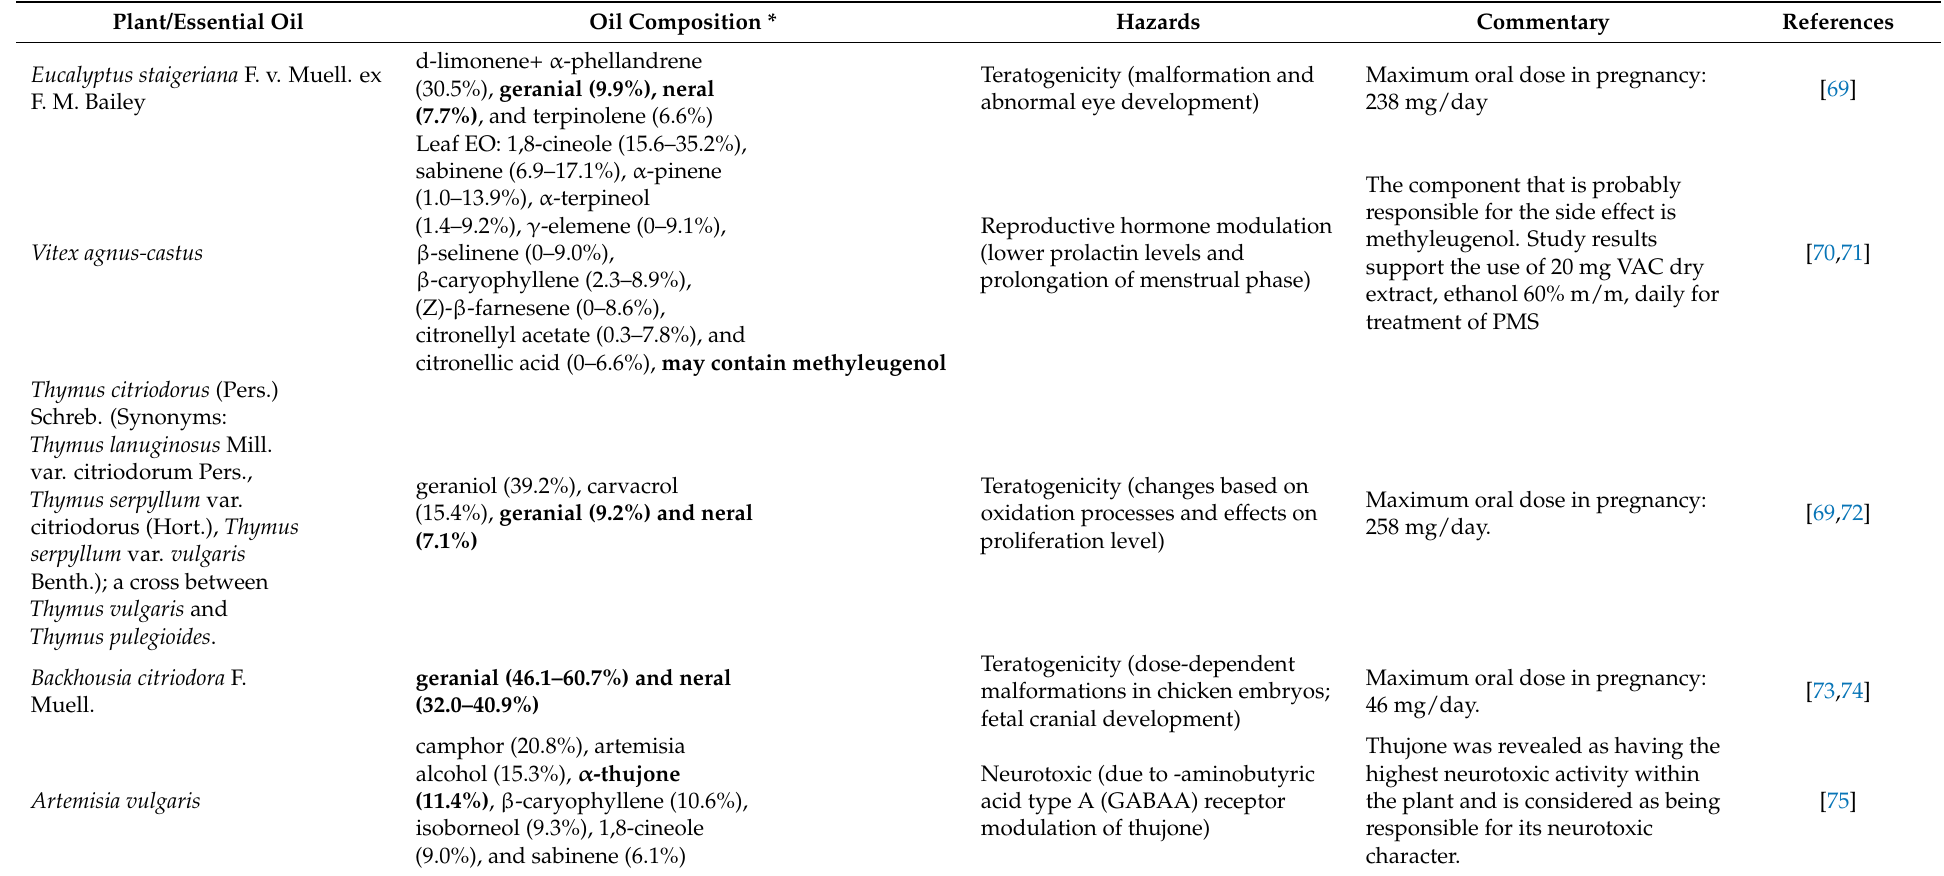
Table 2. Examples of plants and their essential oils rich in monoterpenes and their potential toxic character. Structures of the main components are presented in Figure